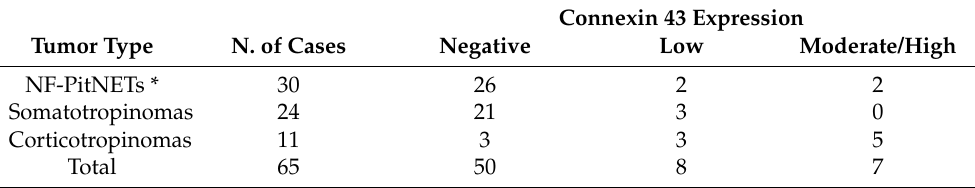
Table 3. Immunoreactivity score of the protein expression of connexin 43 in pituitary neuroendo- crine tumor (PitNET).